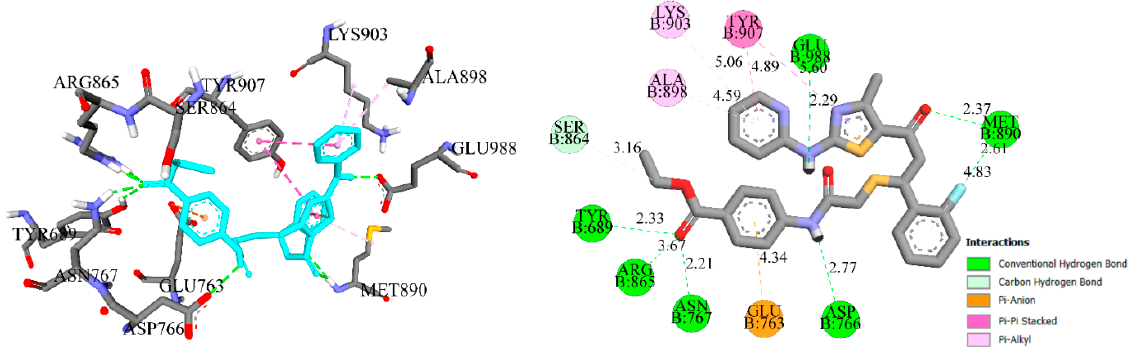
Figure 19. The binding of compound 4 best-generated conformer with the PARP1 (PDB 7KK4).